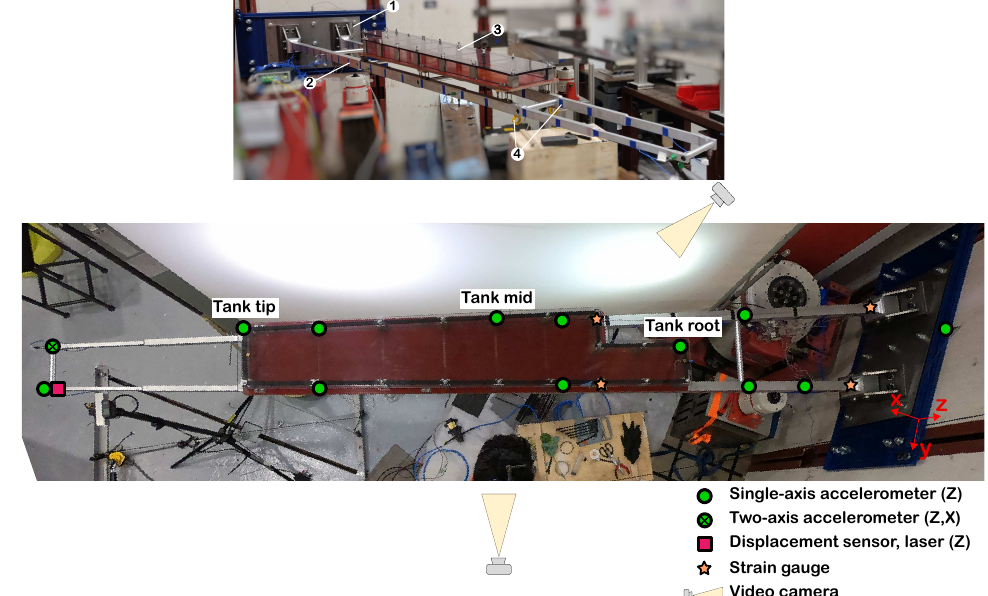
Figure 1. MiniWoT scaled test specimen. Top figure: ( 1 )—Cantilever to the strong wall connection, ( 2 )—scaled structure model, ( 3 )—scaled fuel tank model and ( 4 )—loading points for step release tests. Bottom figure: instrumentation